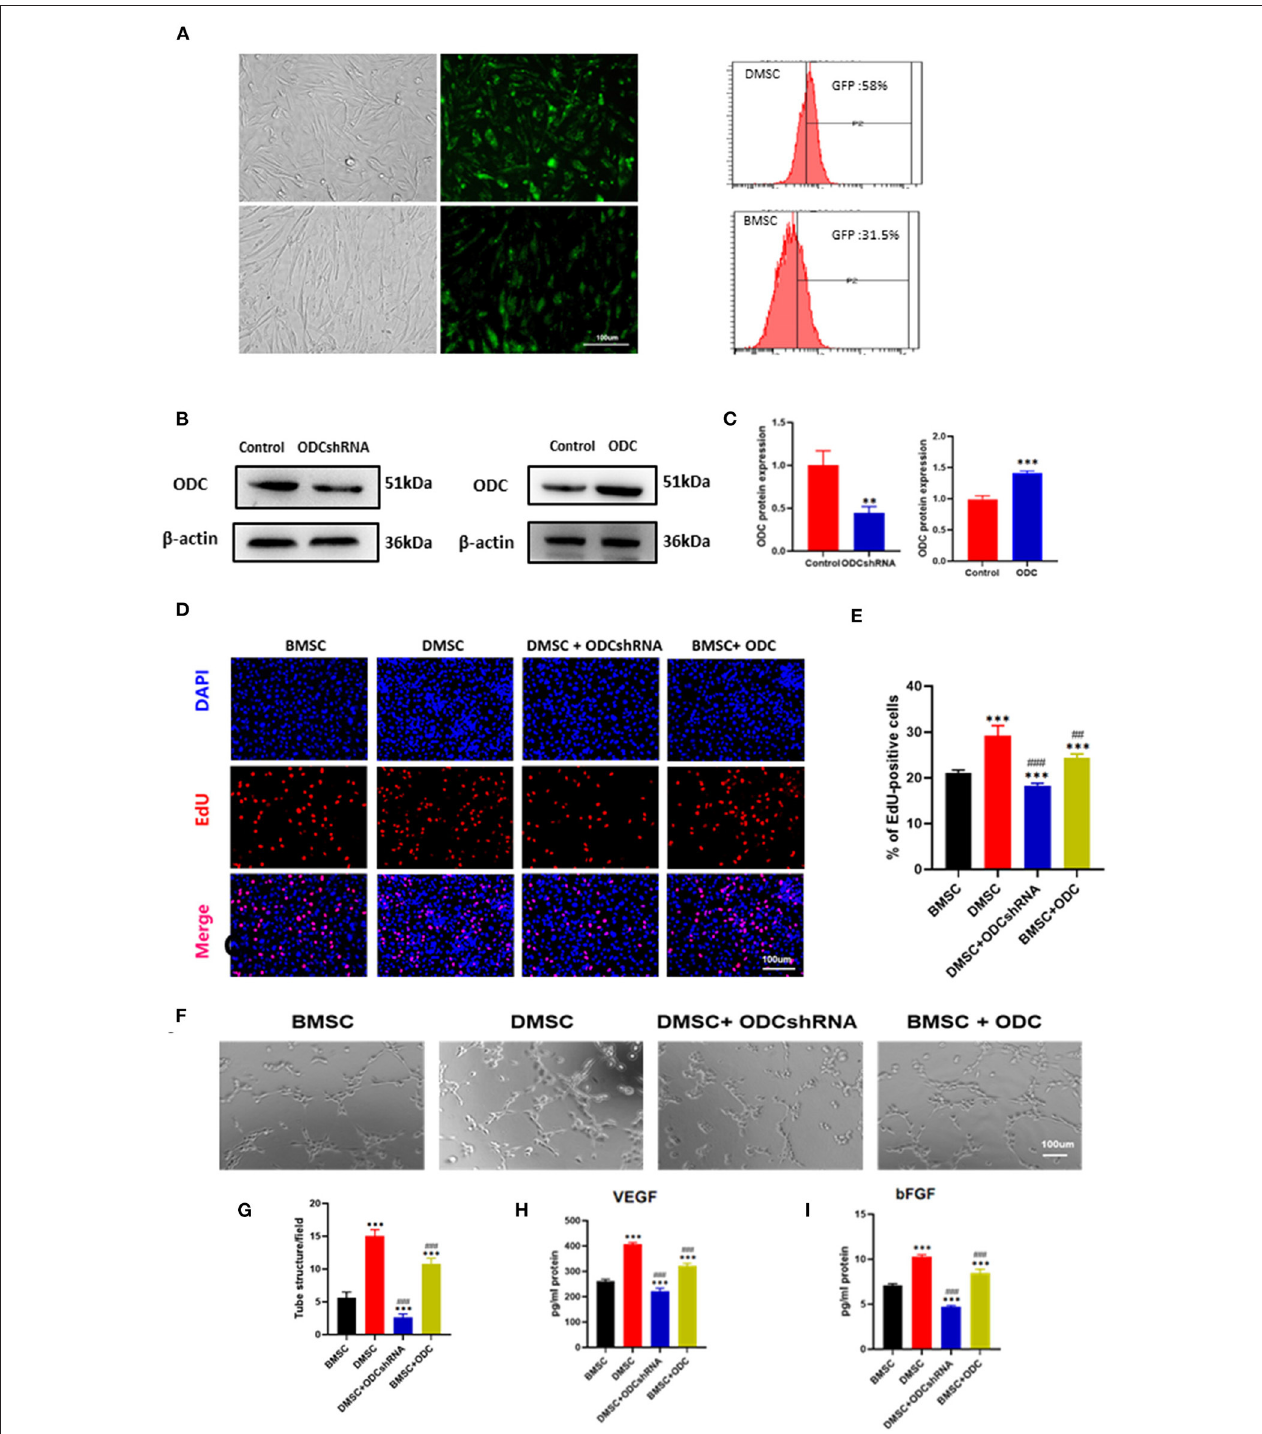
FIGURE 3 | ODC inhibition partly abolished the effects of DMSCs on angiogenesis in vitro . (A) Transfection of plasmid containing GFP gene in stem cells GFP Fluorescence in DMSCs (upper row) and in BMSCs (lower row), transfection efficiency of hMSCs was detected by fluorescence-activated cell sorting. (B,C) ODC protein expression in DMSCs after ODC inhibition and BMSCs after ODC overexpression. (D,E) Representative images of DAPI/EdU staining in DMSCs or BMSCs treated with ODC shRNA or overexpression plasma for 72h, respectively. (F) Representative images of tube formation in HUVECs under different treatment conditions in vitro . (G) Quantitative analysis of tube formation. (H,I) Detection of VEGF and bFGF secretion levels from HUVECs after different treatments in vitro . * P < 0.05, ** P < 0.01, *** P < 0.001, Scale bar, 100 µ m. # P < 0.05, ## P < 0.01, ### P < 0.001.